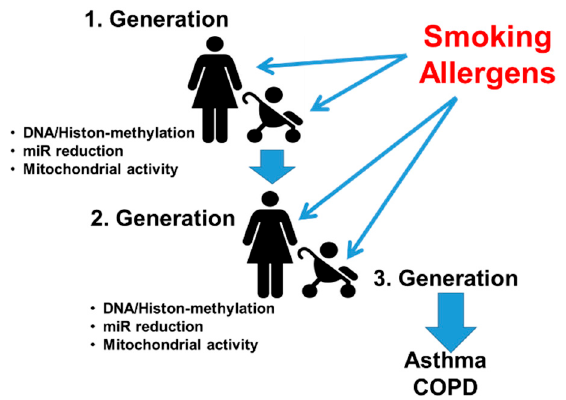
Figure 3. Epigenetic mechanisms may mimic genetic inheritance of asthma susceptibility. However, the reason as to how DNA and protein-methylation or the reduction of specific microRNAs (miR) become constitutive and inheritable remains to be investigated.